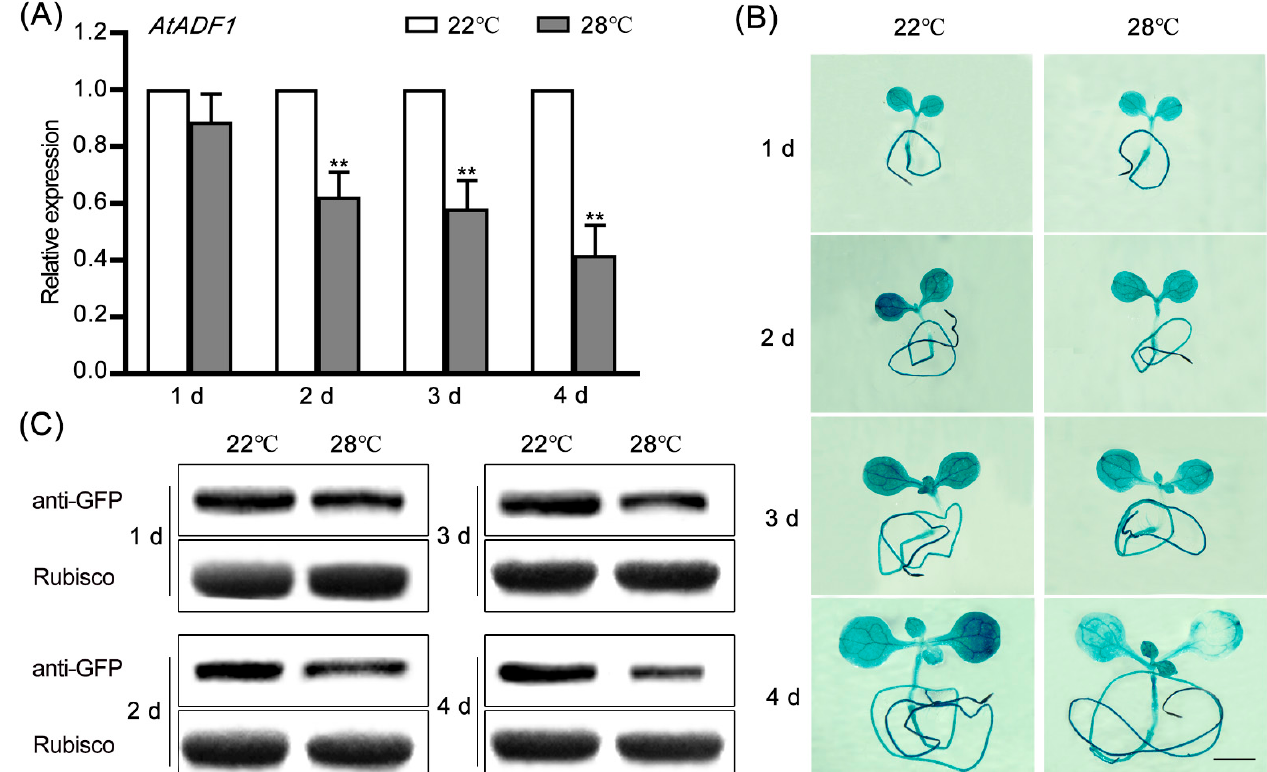
Figure 1. The expression and promoter activity of AtADF1 are inhibited by high temperatures. ( A ) The relative expression of AtADF1 in 3-day-old wild type seedlings treated at 28 °C for 1, 2, 3, and 4 d was determined by RT-qPCR. 18S was used as an internal control. Values are means ± SD from three independent replicate experiments (Student’s t -test, ** p < 0.01). ( B ) The expression pattern of AtADF1 was revealed by GUS staining of pADF1:GUS transgenic plants under high temperature. Scale bars = 0.25 cm. ( C ) Western blots using proteins were extracted from AtADF1 -GFP seedlings incubated at high temperatures. Rubisco was used as a loading control.